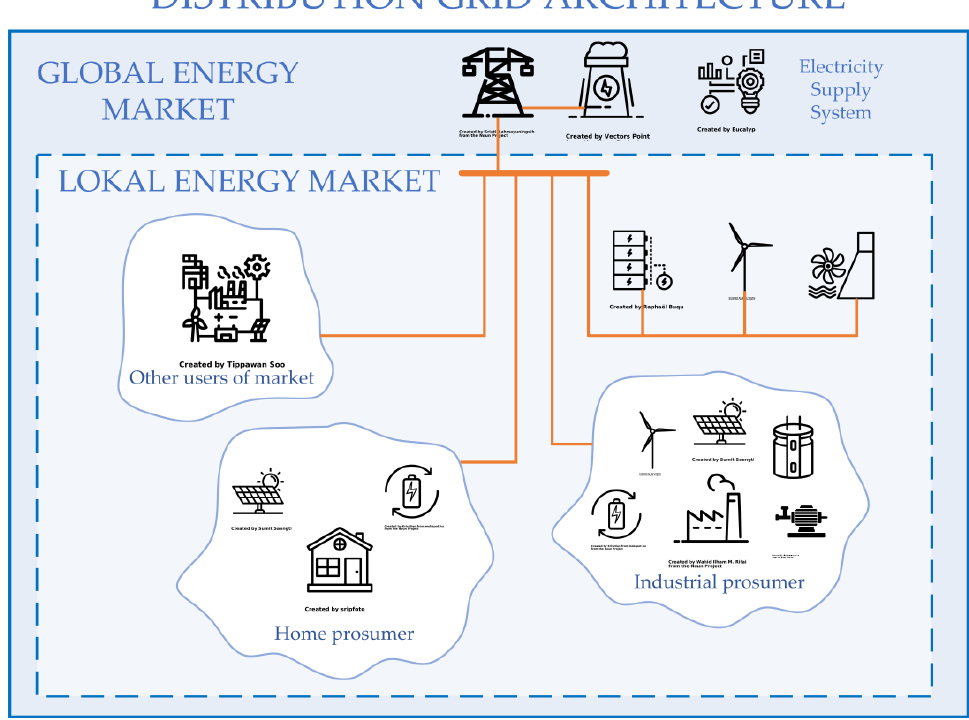
Figure 4. Modern architecture of distribution grids detailing users and the concept of participation in the local and global energy market.